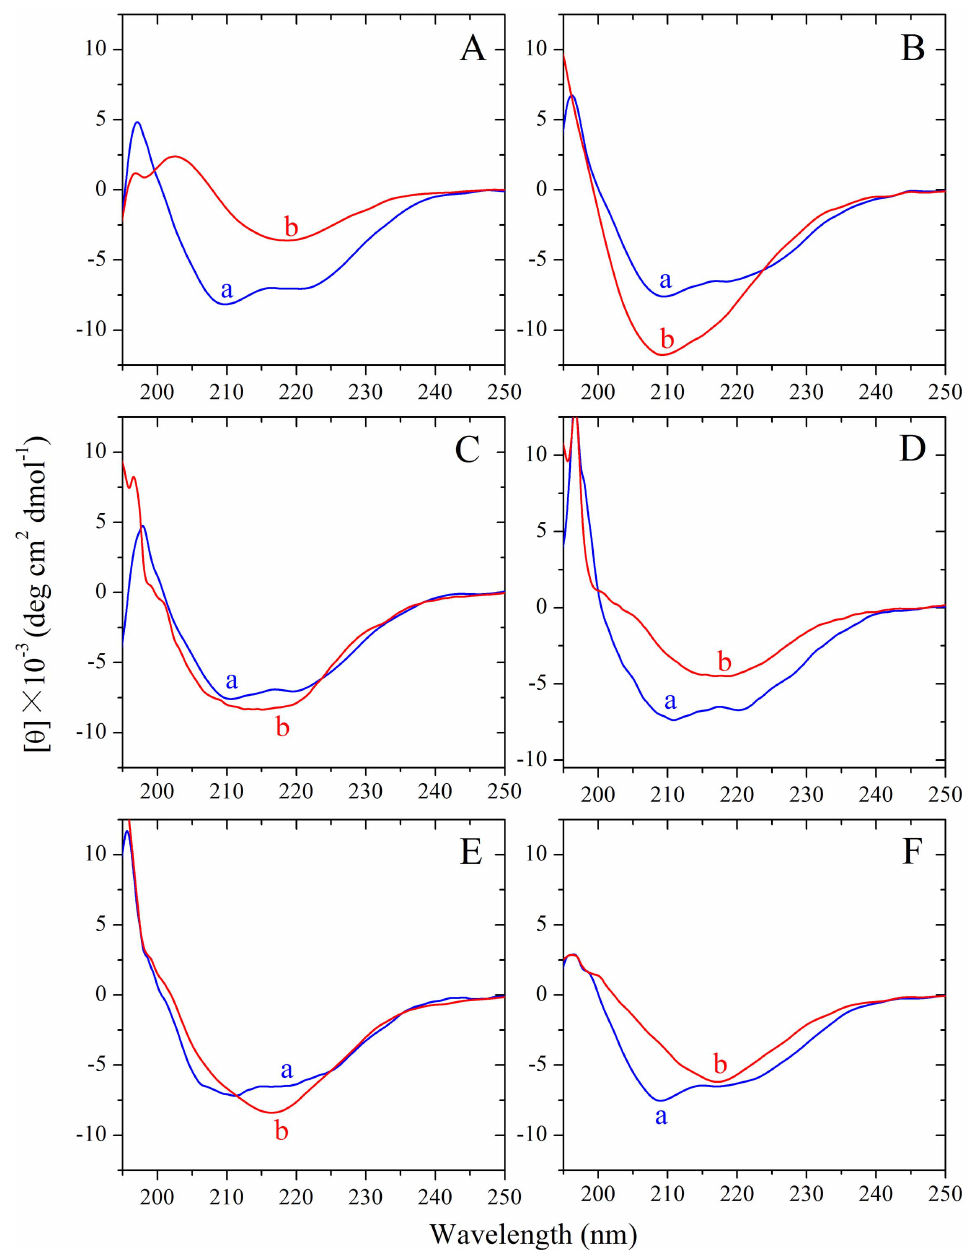
Figure 4. Secondary structural changes of human (A, C, and E) and rabbit (B, D, and F) chimera PrP isoforms monitored by far-UV CD. Curve a: native human/rabbit chimera prion proteins, and Curve b: amyloid fibrils produced from human chimera and rabbit chimera, in the absence of a crowding agent (A and B) and in the presence of 150 g/l Ficoll 70 (C and D) or 100 g/l Ficoll 400 (E and F), respectively. The incubation time was chosen within a time range of the plateau of each kinetic curve of ThT fluorescence shown in Fig.